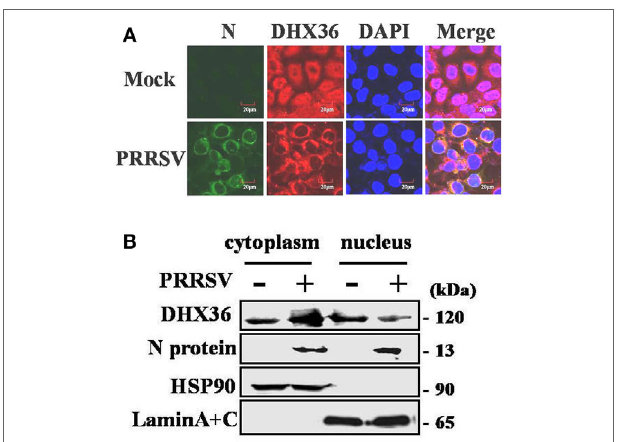
FigUre 2 | Effect of porcine reproductive and respiratory syndrome virus (PRRSV) infection on the subcellular distribution of DExD/H-box helicase 36 (DHX36). (a) MARC-145 cells were mock-infected or infected with PRRSV (MOI = 0.5). At 24 hpi, cells were fixed for immunofluorescence analysis of DHX36 (red), N protein (green), and nucleus marker diamidino-2-phenylindole (blue) localization and merged by confocal microscopy. (B) Nuclear and cytoplasmic fractionation of PAMs infected with PRRSV for 24 h. Each nuclear and cytosolic fraction was prepared from PAMs and subjected to Western blot analysis with an antibody specific for DHX36, LaminA + C as a nuclear protein marker, HSP90 as a cytosolic protein marker, or the PRRSV N protein.